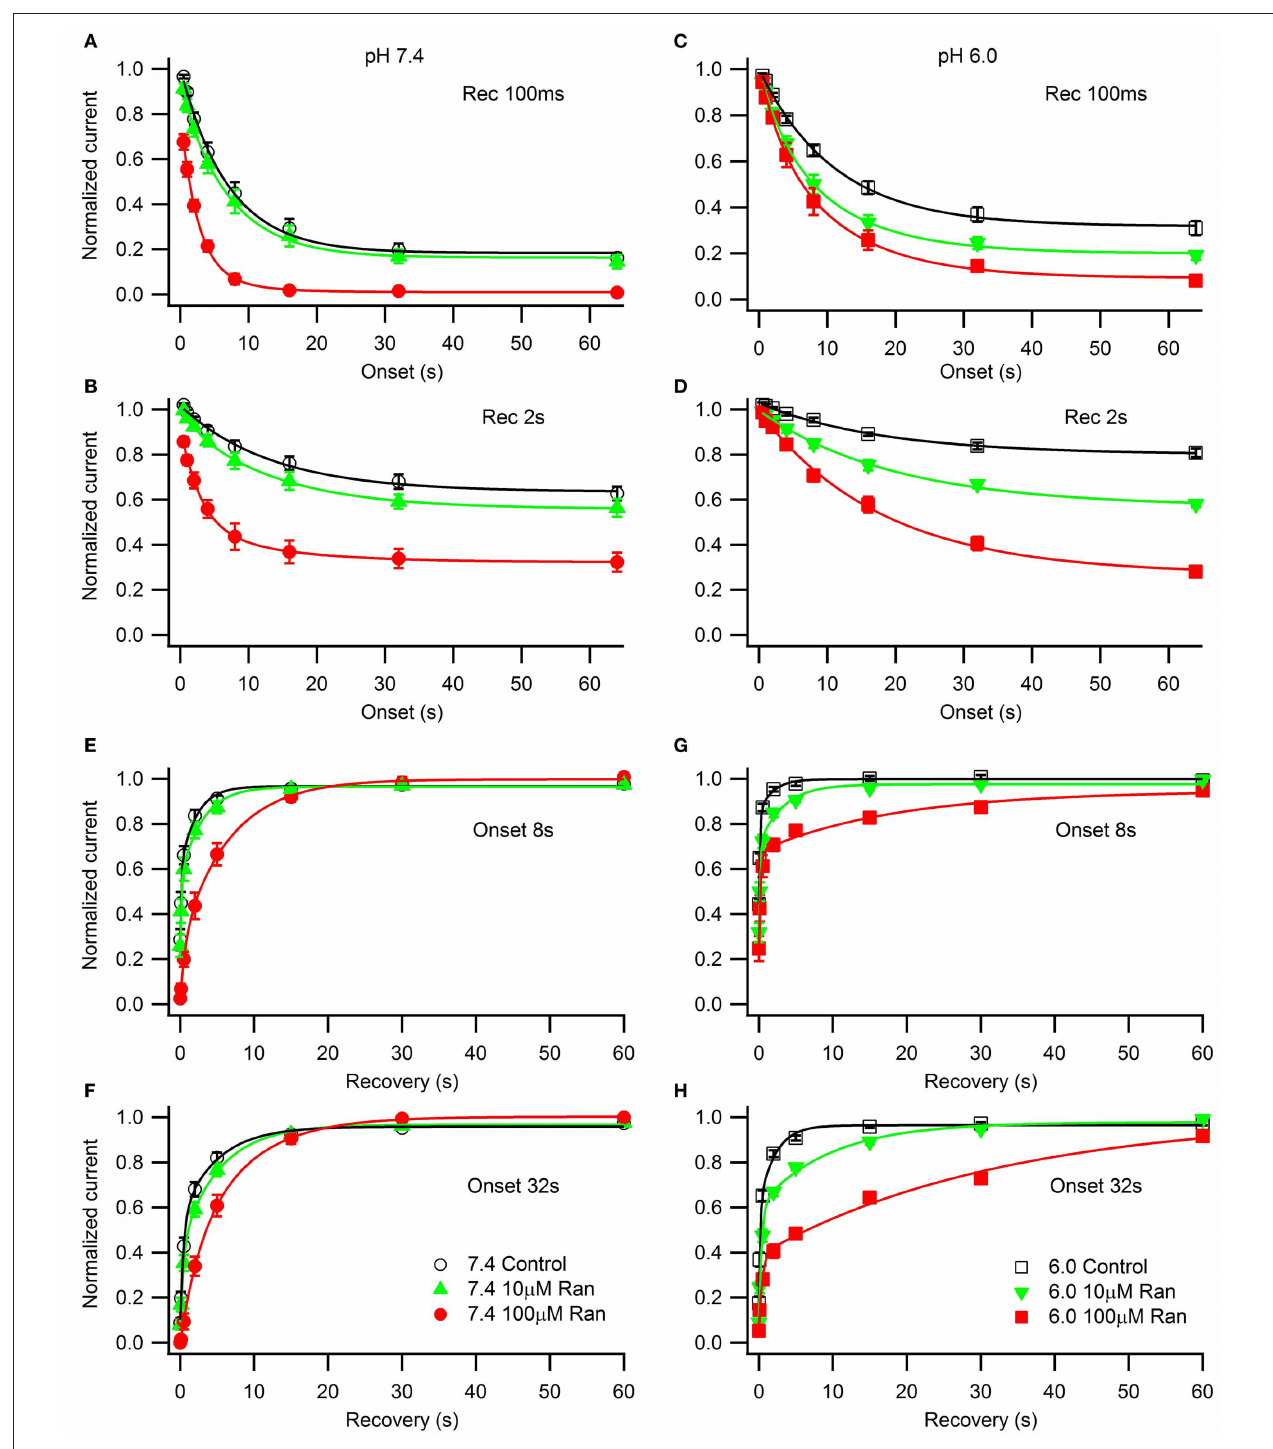
FIGURE 8 | Slow inactivation onset and recovery and effects of ranolazine at pH 7.4 (left) and 6.0 (right). Onset of slow inactivation (A–D) was induced by conditioning pulses to − 10mV ranging from 500ms to 64s. Amount of slow-inactivated channels (control, open black symbols) or a combination of slow-inactivated and ranolazine blocked channels (closed symbols) was assessed by 5ms test pulses to − 10mV after either 100ms (A,C) or 2s (B,D) recovery at − 130mV. Onset kinetics were fitted